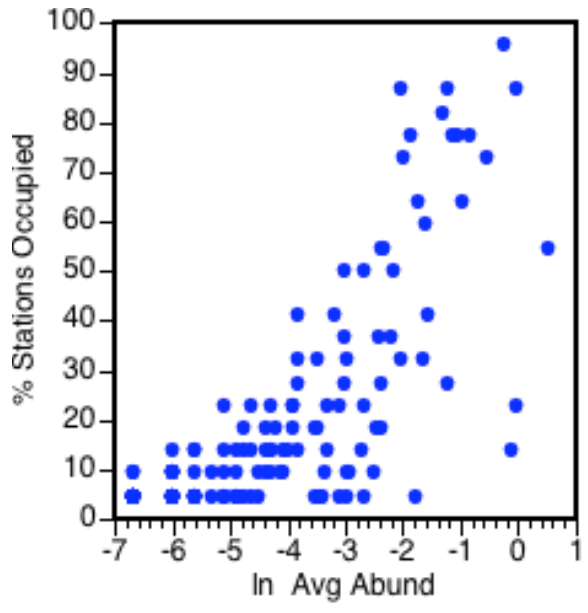
Fig. 8. Scatter plot of occurrence rate of tintinnid species, as a % of stations occupied, against average abundance across all the stations. The positive relationship between average abundance and occurrence (Rho value of 0.796, p< 0.0001) supports the idea that overall population size determines occurrence rate. Recall that morphology appears to be unrelated to occurrence rate (Fig. 7).